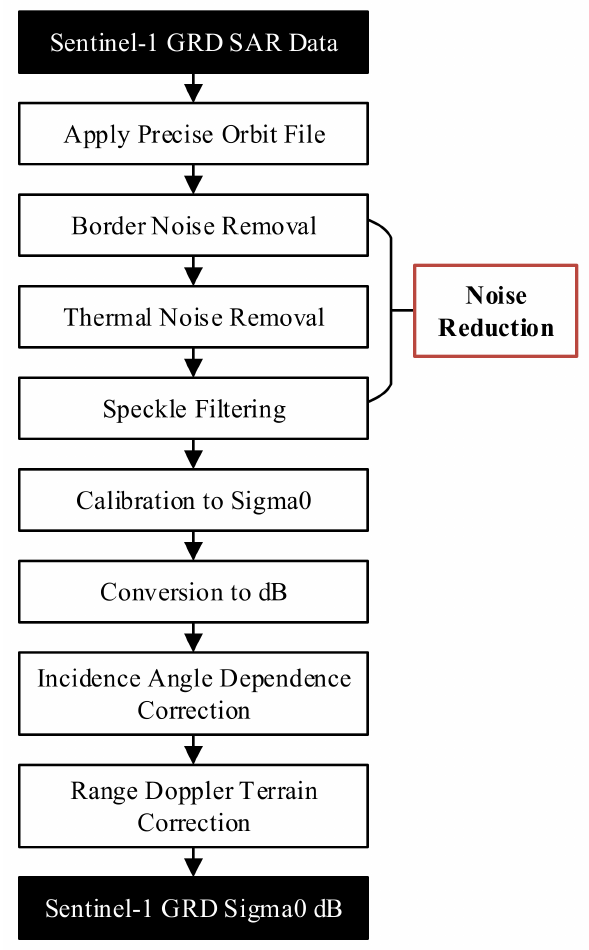
Figure 3. Sentinel-1 GRD SAR preprocessing